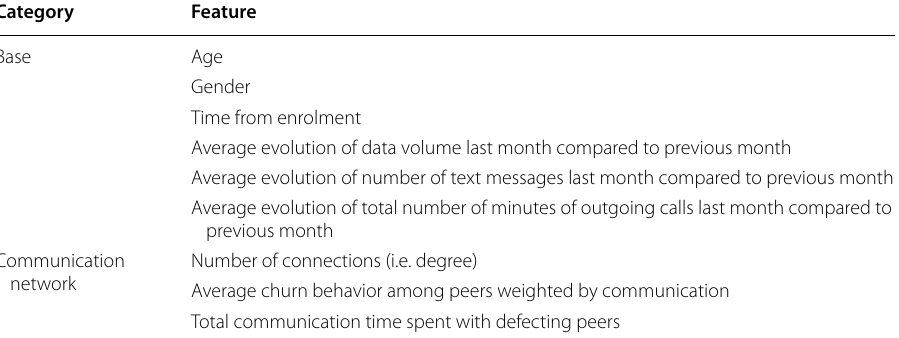
Table 1 Base and communication metrics